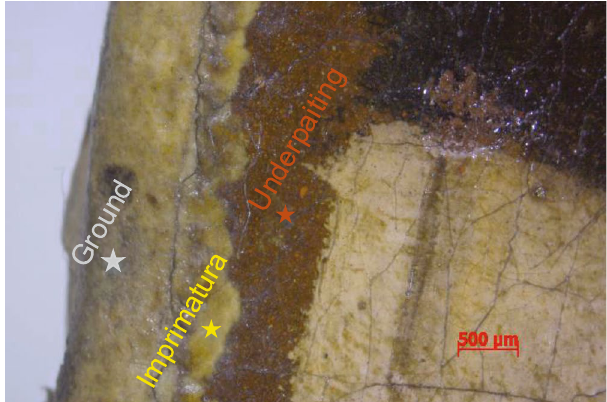
Figure 9. The optical microscopic image of a small region at the edge of Madonna in Preghiera . The applications of ground, imprimatura, and the underpainting can be clearly identified.